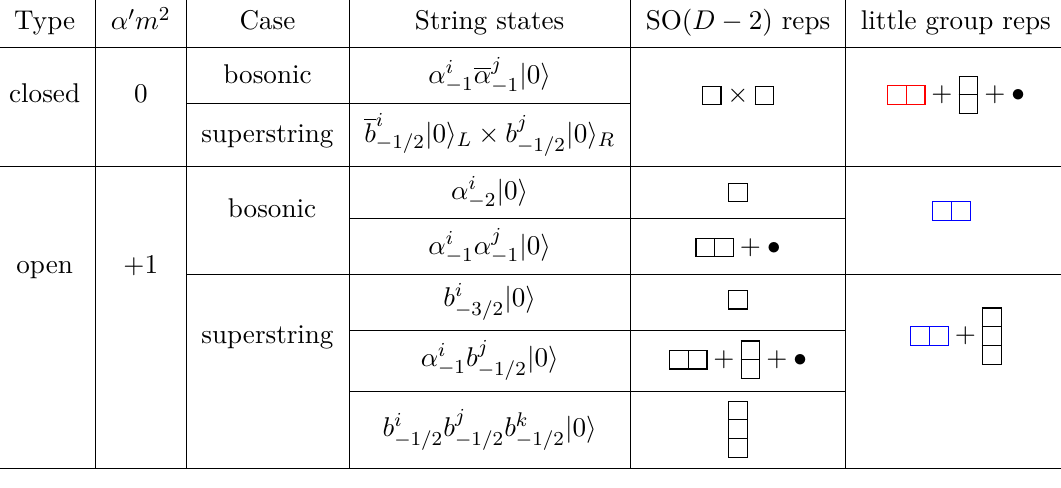
Table 2 . The relevant bosonic and superstring mass levels ( i = 1 , 2 , . . . , D − 2